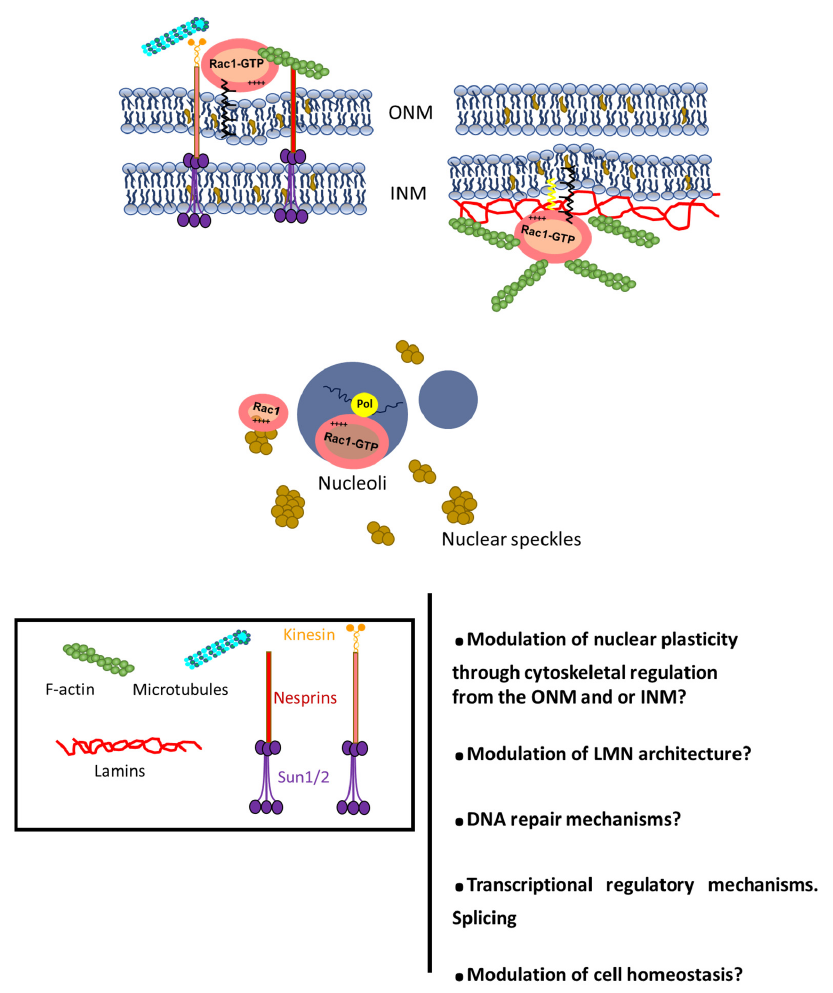
Figure 3. Potential mechanisms for RhoGTPases as modulators of nuclear membrane architecture and organization and nuclear function. ONM: Outer nuclear membrane, INM: Inner nuclear membrane. LMN: Nuclear lamina.